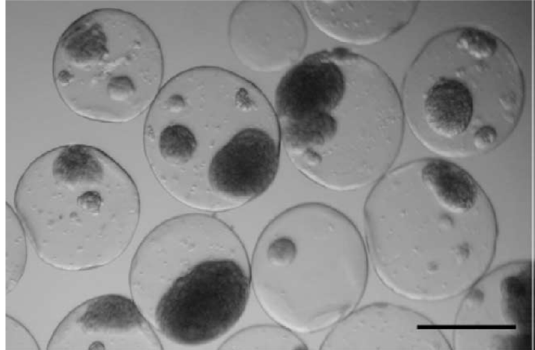
Figure 17. Adapted with permission from S. Sakai et al. [88]. Copyright 2002 Elsevier. License number 5318830910749. Micrograph of encapsulated islets in Alg/AS/Alg microcapsules. The bar represents 500 μ m.